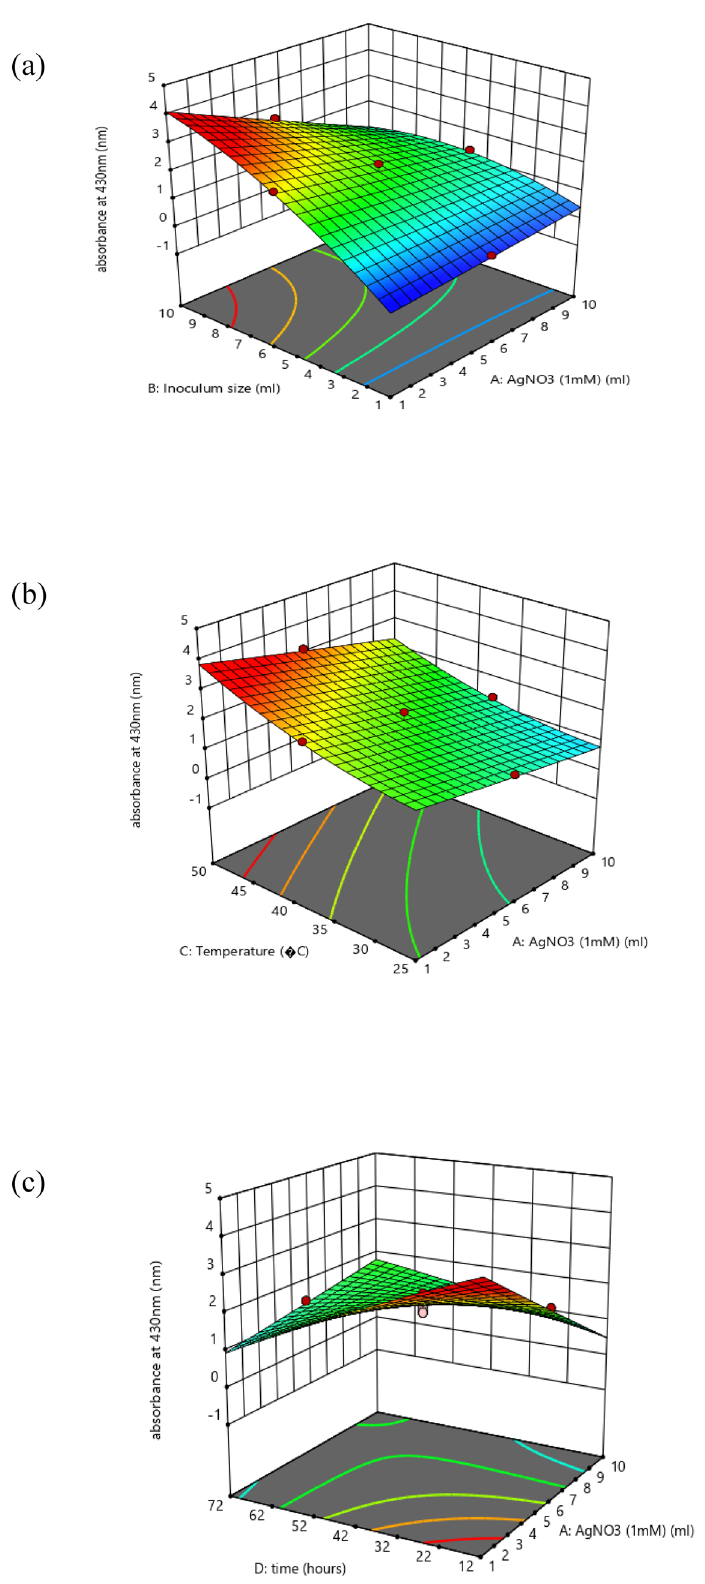
Figure 7. Three dimensional graphics for response surface optimization by plotting absorbance versus ( a ) silver nitrate (ml) and inoculum size (ml), ( b ) silver nitrate (ml) and temperature (°C), ( c ) silver nitrate (ml) and time (hours), ( d ) silver nitrate (ml) and pH, ( e ) inoculum size (ml) and temperature (°C), ( f ) inoculum size (ml) and time (hours), ( g ) inoculum size (ml) and pH, ( h ) temperature (°C) and time (h), ( i ) temperature (°C) and pH, ( j ) time (h) and